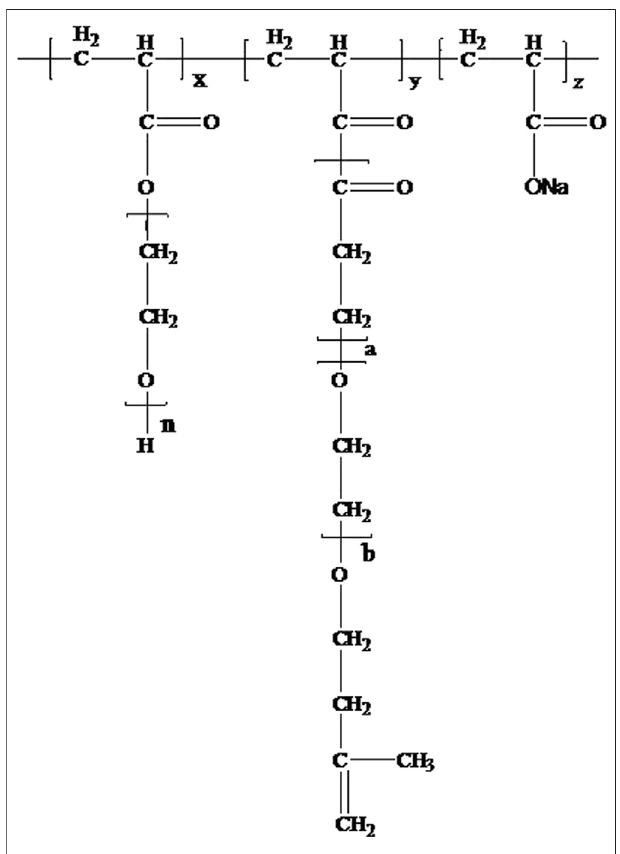
FIGURE 1 | Chemical structure of commercial Sika